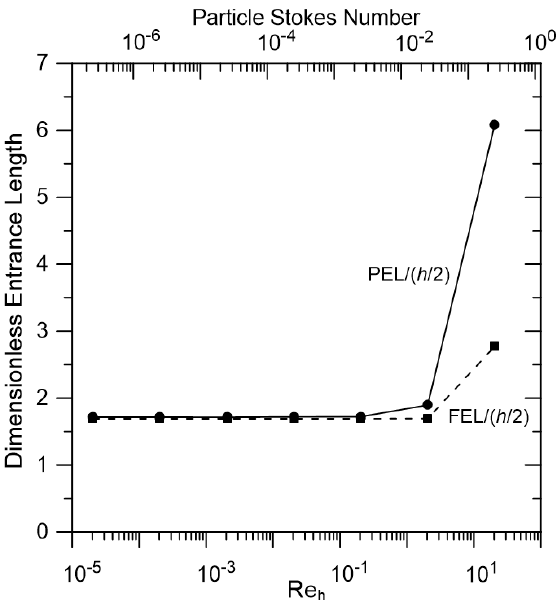
Figure 8. Effect of Re h on PEL and FEL. Results are presented for a system with λ = 0.1, particle specific gravity = 1.1, Y initial = 1, X initial = − 5 and r c /(h/2) = 1.